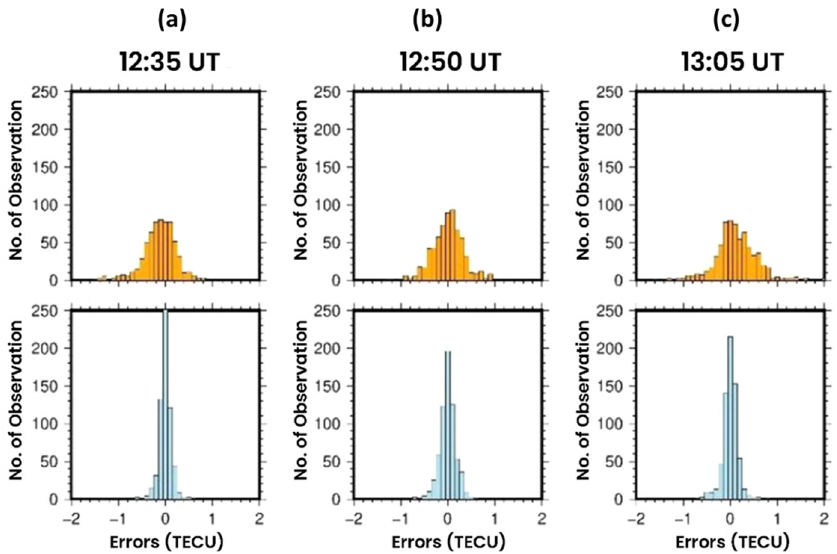
Figure 4. The histograms of raw (upper panel) and calculated STEC anomaly data (lower panel) at three-time epochs: ( a ) 15 min before mainshock, ( b ) at mainshock, and ( c ) 15 min after